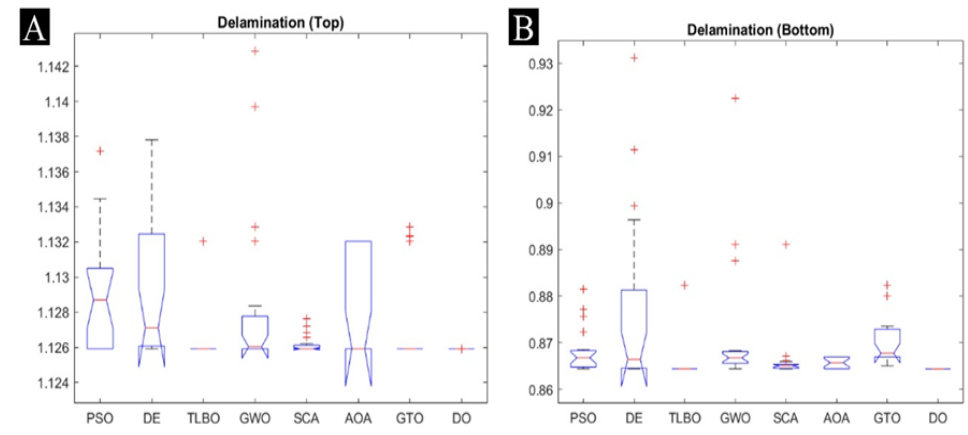
Figure 8. Boxplots of different nature-inspired algorithms when optimizing the delamination sizes at